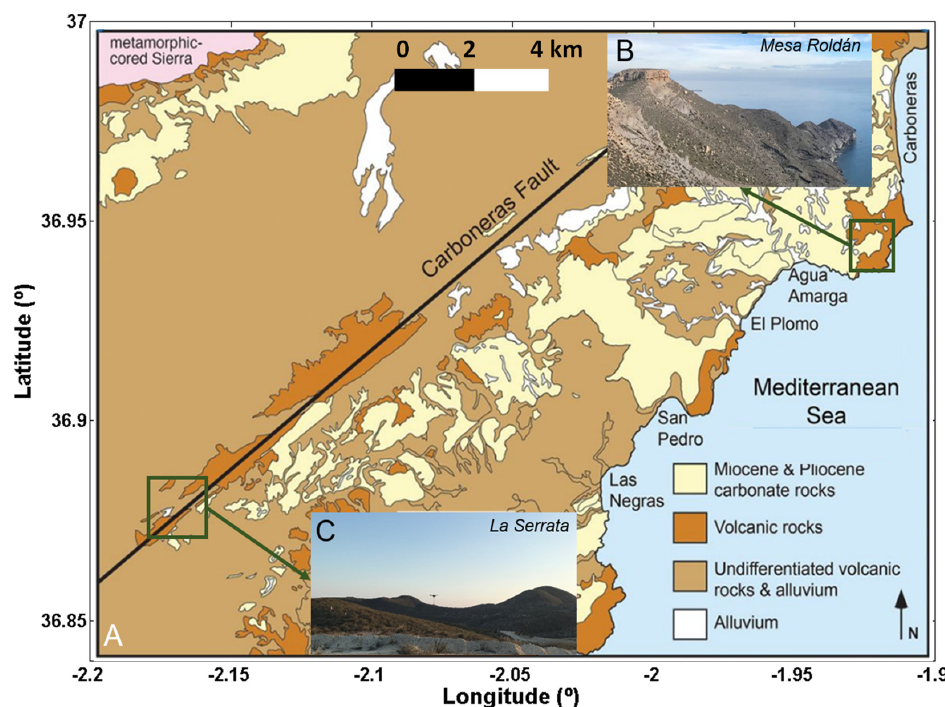
Figure 15. ( A ) Cabo de Gata area showing the Carboneras Fault and the two sites of study: ( B ) Mesa Roldán and ( C ) La Serrata.